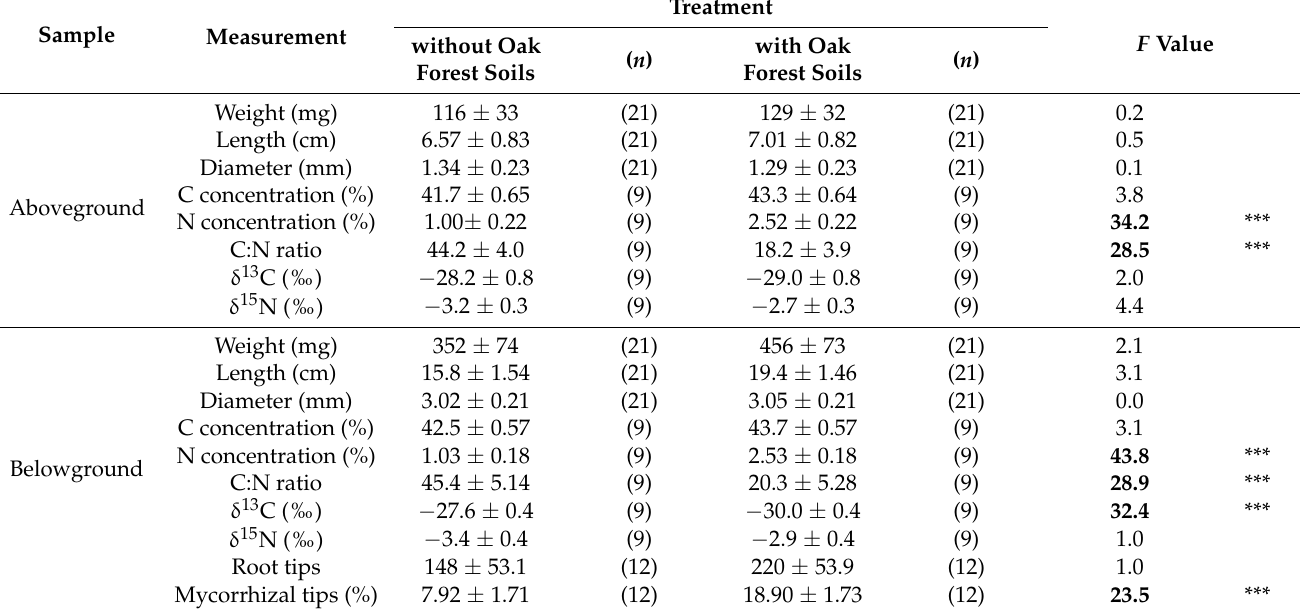
Table 1. The size and chemical properties (least square mean ± SE) of the sowed seedlings of June 2018 under Experiment 1 (sowing seeds) in the black locust forest without and with the oak forest soils. ( n ) shows the number of samples. The right side shows F -values and p -values (*** p < 0.001) based on ANOVA for the LMM with the treatment (with or without the oak forest soils). The models were performed with the plot as a random variable. The significant results were